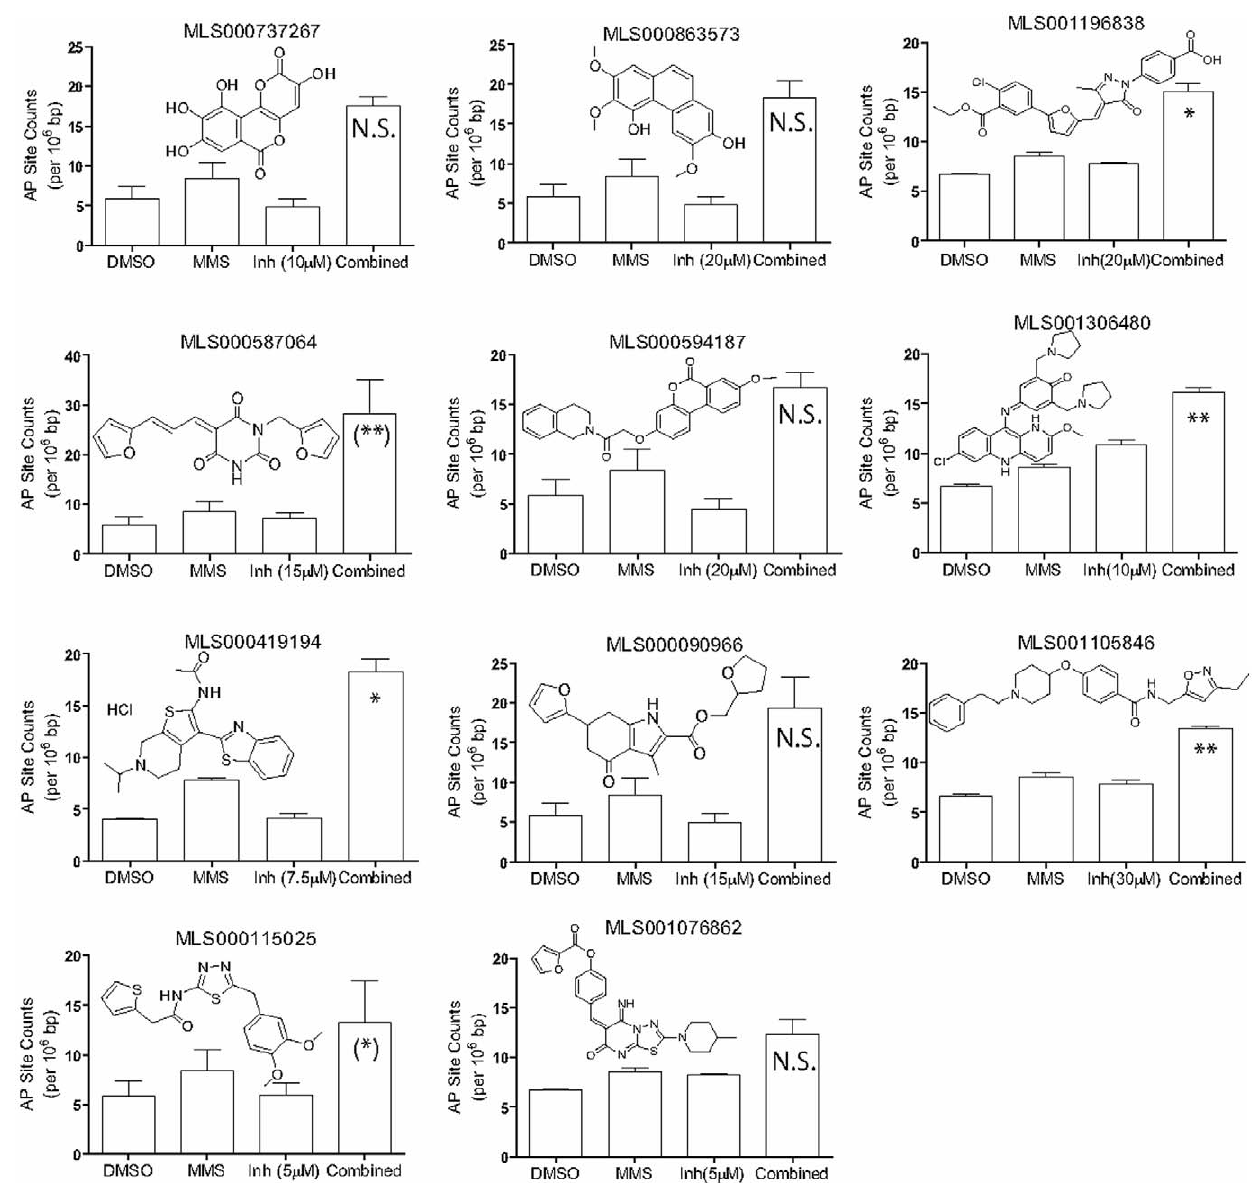
Figure 8. AP-site accumulation. HeLa cells were exposed to each compound shown in the absence and presence of 275 m M MMS, and total genomic AP sites were measured as described in Methods. The number of AP sites per 10 6 base pairs of genomic DNA are presented as the average and standard deviation of two independent measurements. P-values (*P , 0.05, **P , 0.01) were calculated to evaluate the significance of the enhancement of AP site levels produced by the combined treatment versus MMS alone. N.S., not significant (P $ 0.05); P-value designations for MLS000587064 and MLS000115025 shown in parentheses are derived from the repeat testing reported in Figure S1.